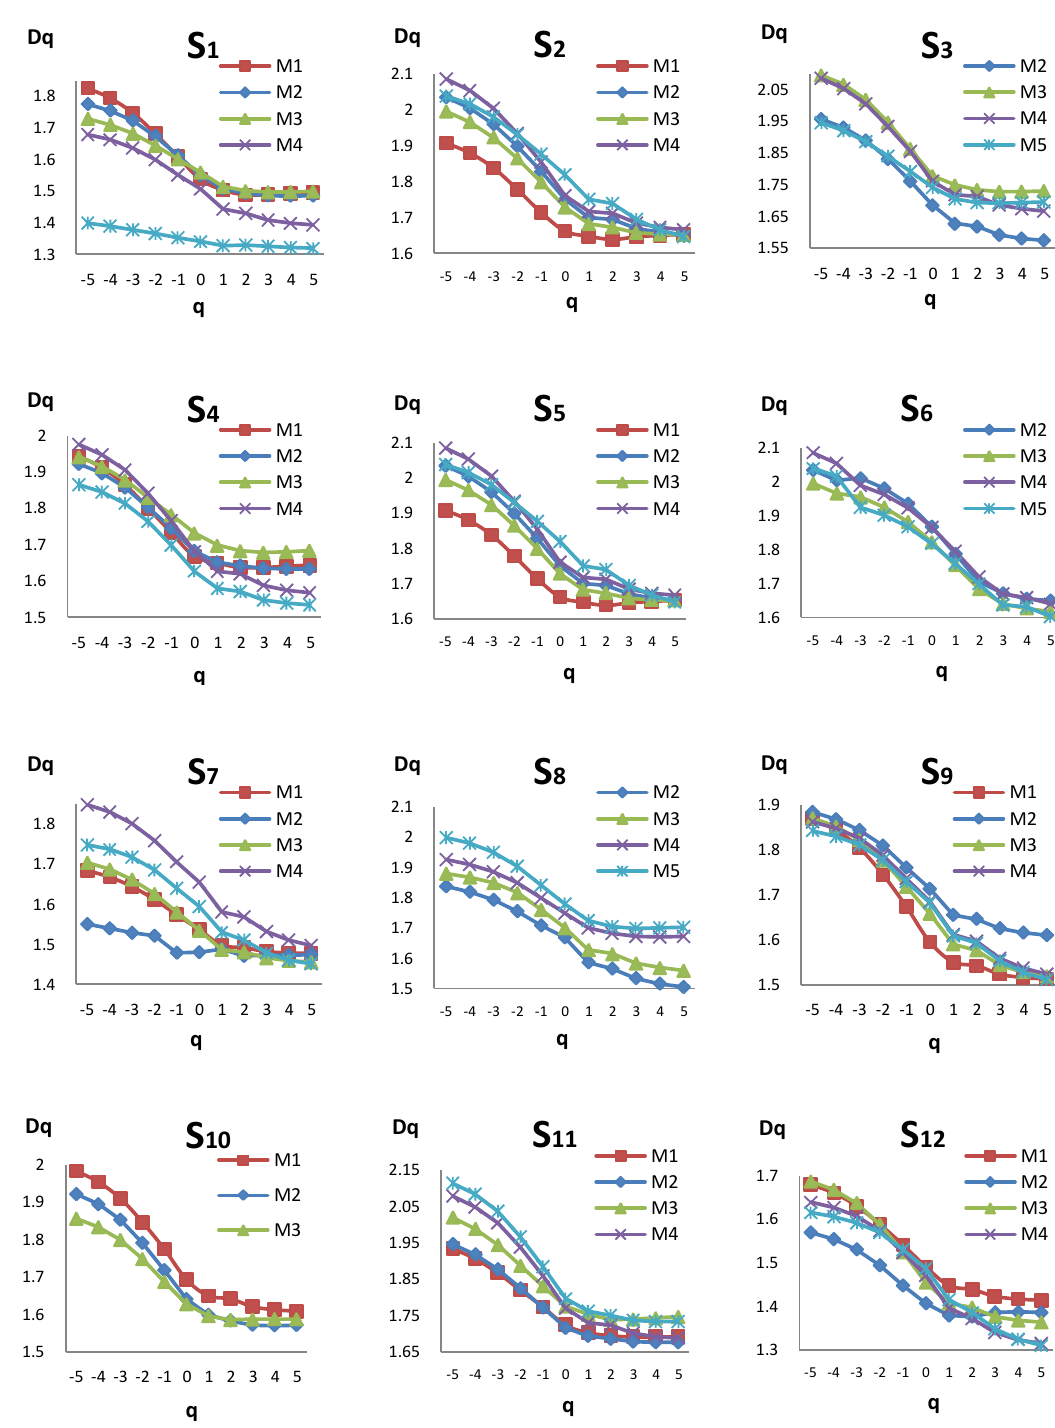
Fig. 14. Results of multifractal analysis for the 13 samples. Plots of multifractal dimension D q versus moment q, q (cid:15) [ − 5, 5], at magnifications: 12000x (M 1 ) , 5600x (M 2 ), 3000x (M 3 ), 1700x (M 4 ) and 800x (M 5 )